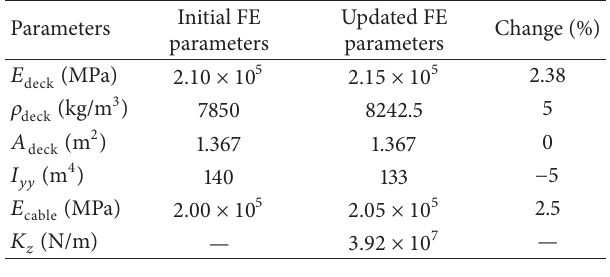
Table 8: Updated parameters of the bridge.